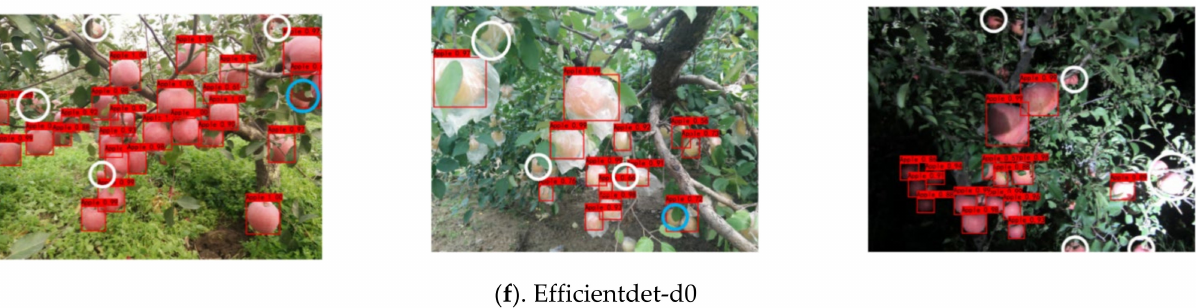
Figure 9. Comparison of ShufflenetV2-YOLOX with other advanced networks for apple detection effects.